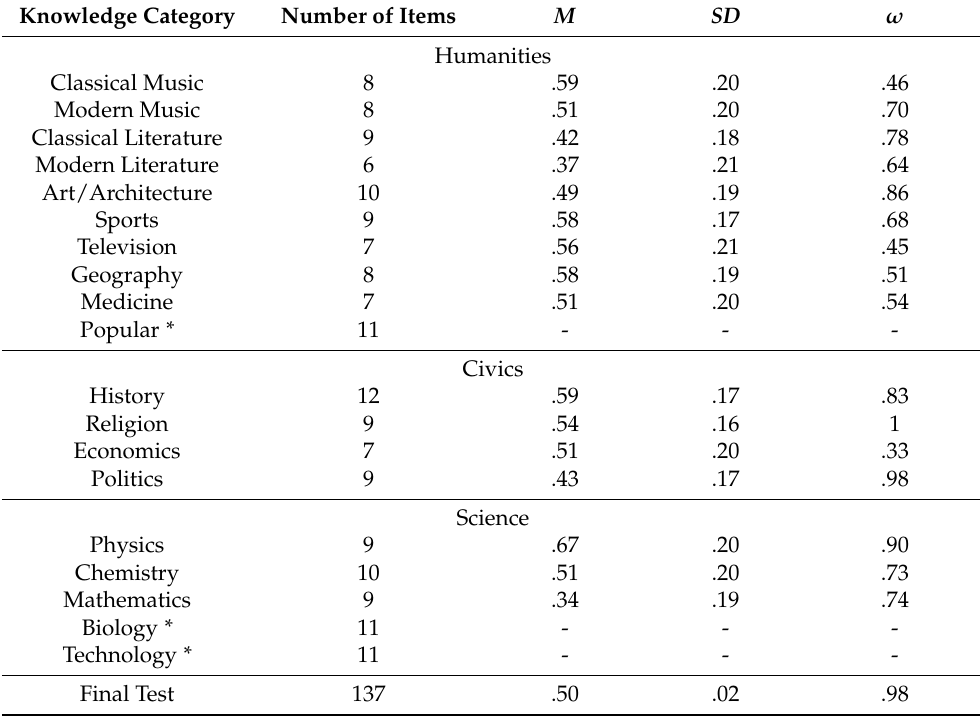
Table 3. Descriptive Statistics and Omegas of Knowledge Categories and the Final